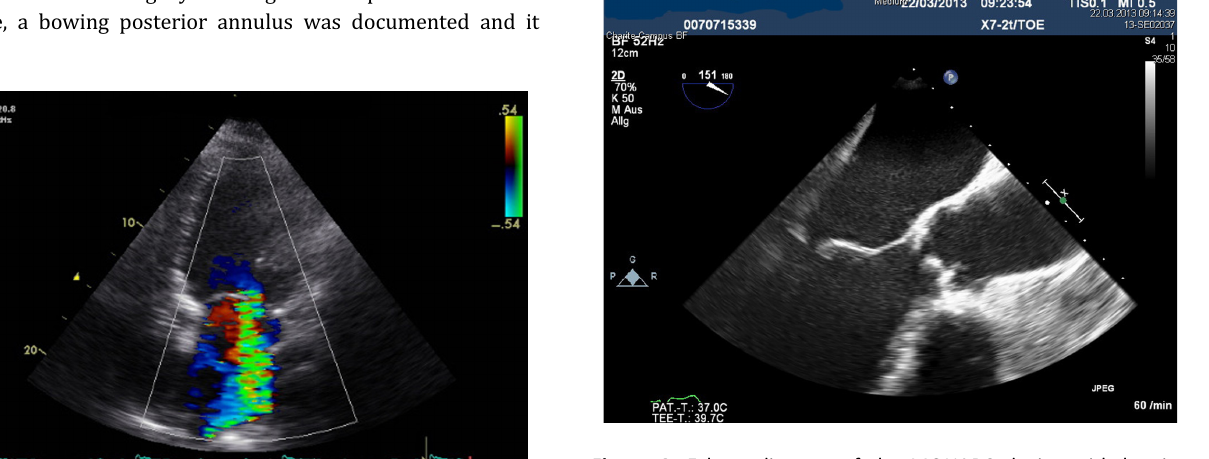
Figure 4 . Echocardiogram of the MONARC device with bowing the posterior annulus and dif fi culty to evaluate the posterior lea fl et length and